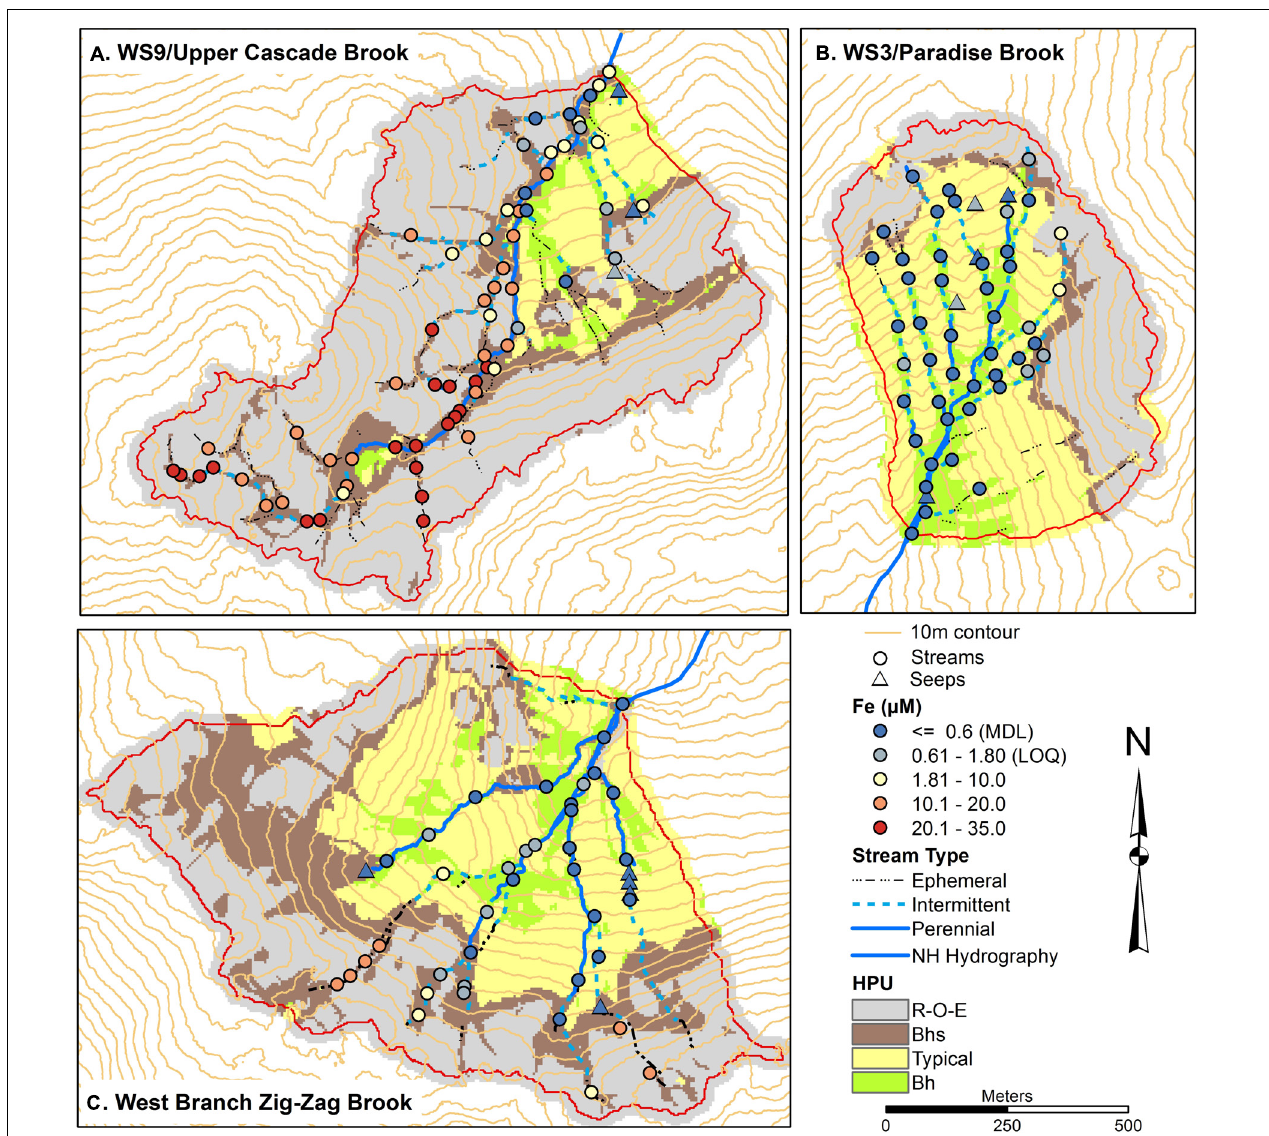
FIGURE 5 | Soils maps for W9 (A) , W3 (B) , and West Branch Zig Zag Brook (C) with variation in surface water iron (Fe) concentrations from a synoptic survey conducted July 22–23, 2015. Surface water samples were classified as streams (circles) or seeps (triangles). Soil units include bedrock outcrops, bedrock Histosols, and E podzols (R–O–E), Bhs podzols (Bhs), typical podzols (Typical), and Bh podzols